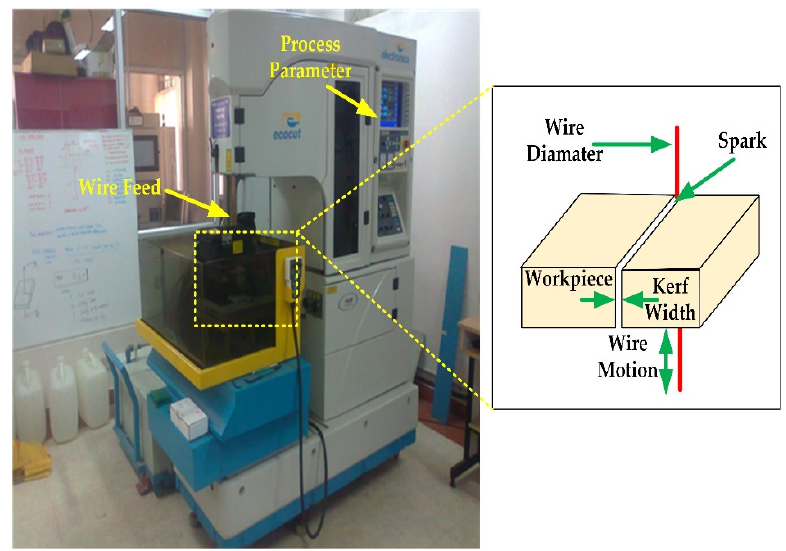
Figure 2. WEDM setup.